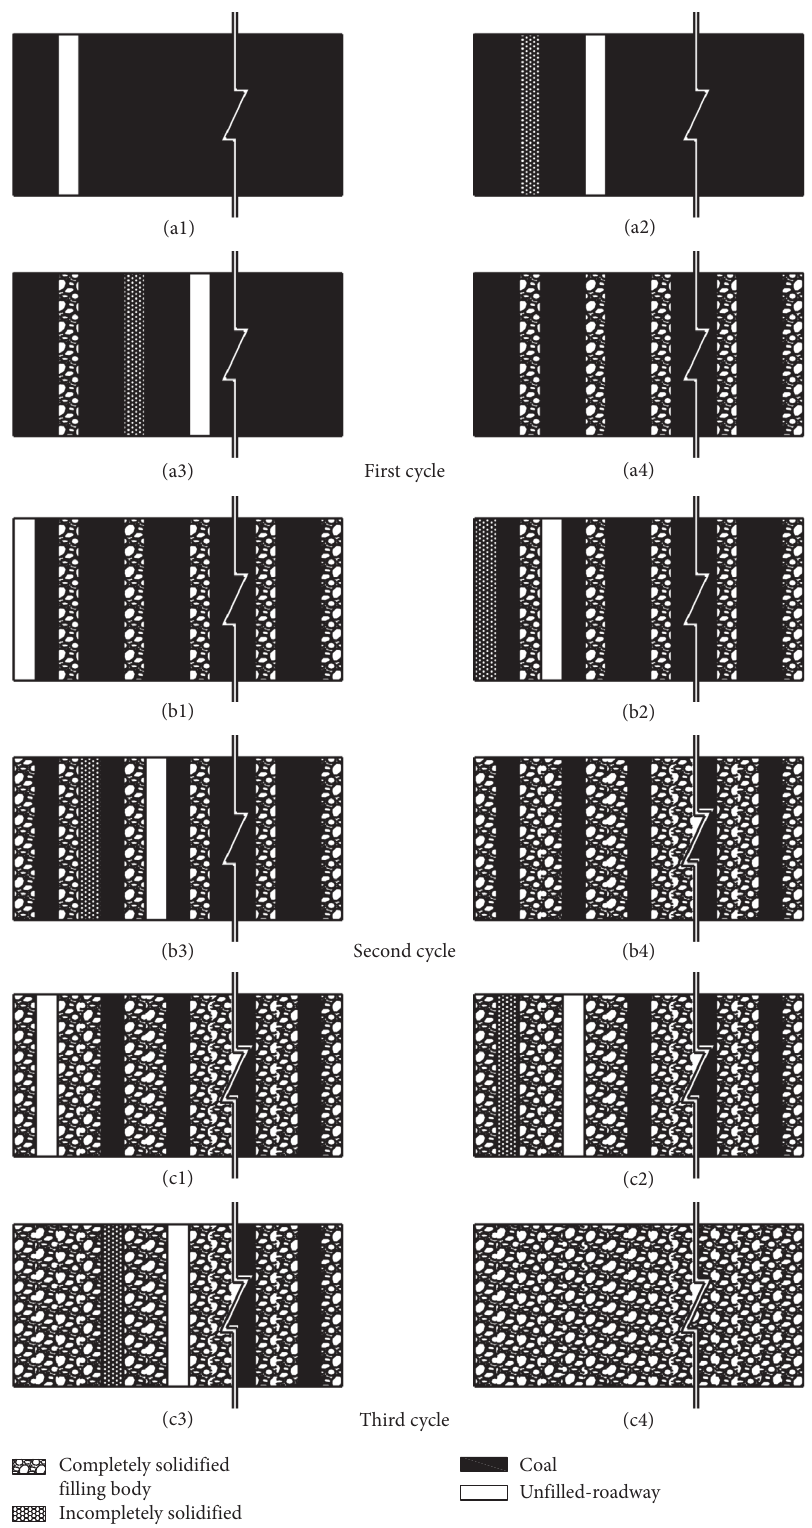
Figure 1: Cycle diagram of roadway mining with cemented